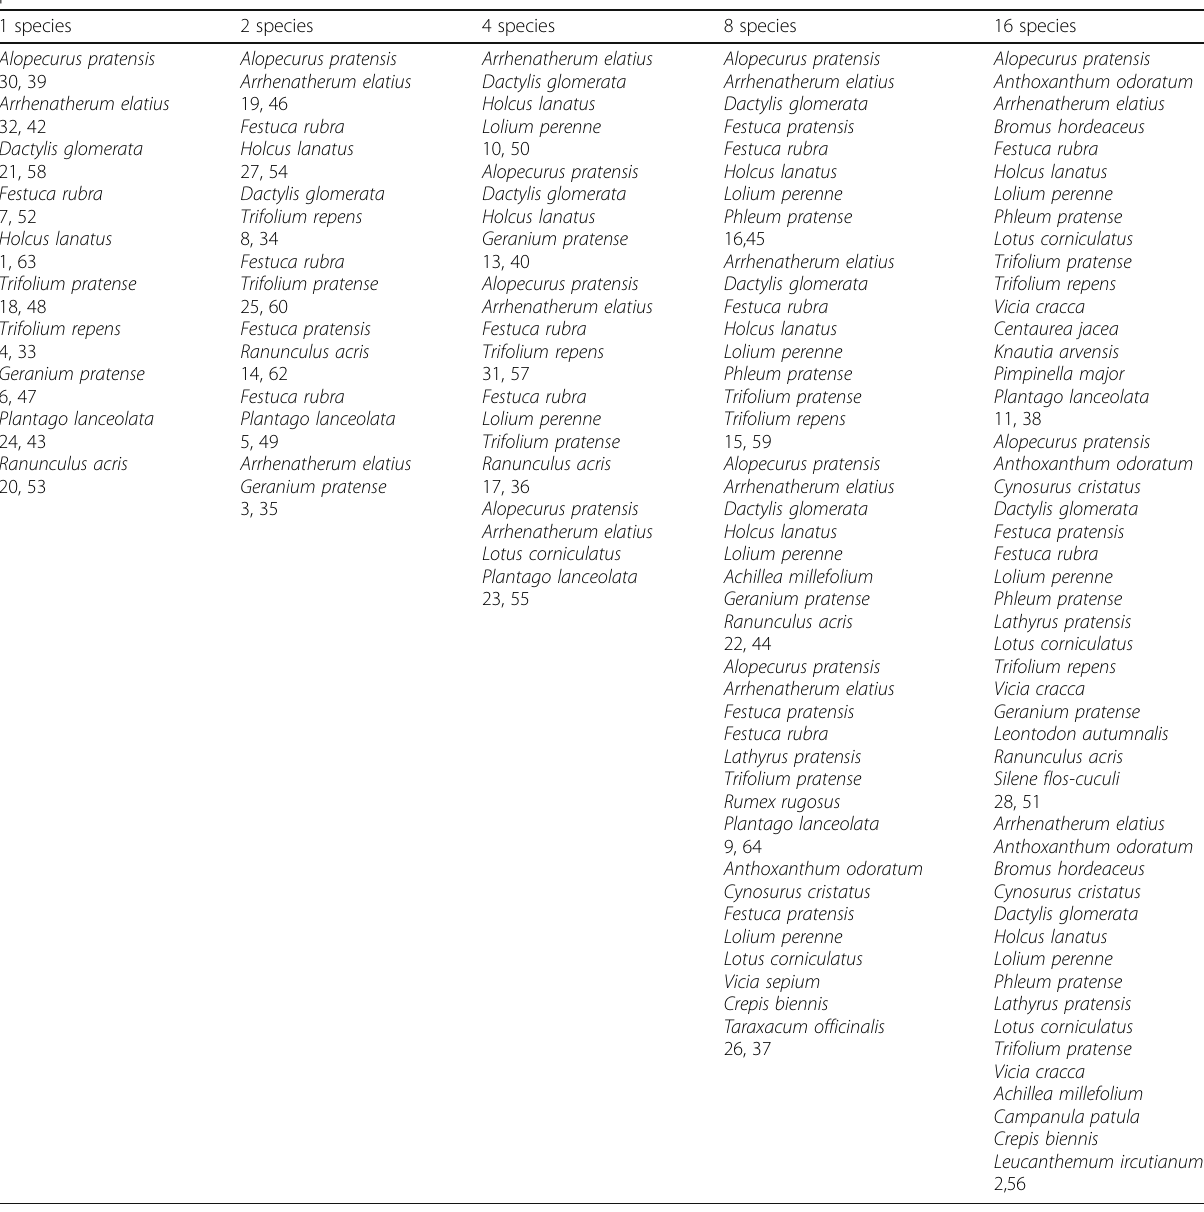
Table 1 List of species planted in 1996. Each column indicates number of species, species name, and plots where species are